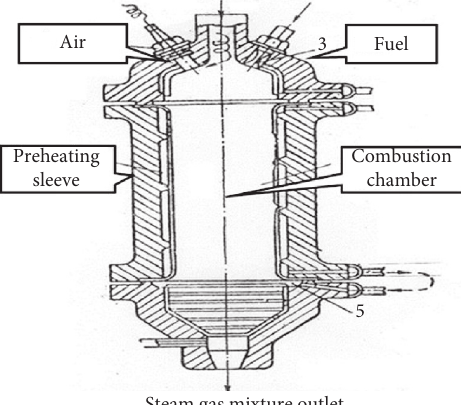
Figure 9: Multielement thermal fluid